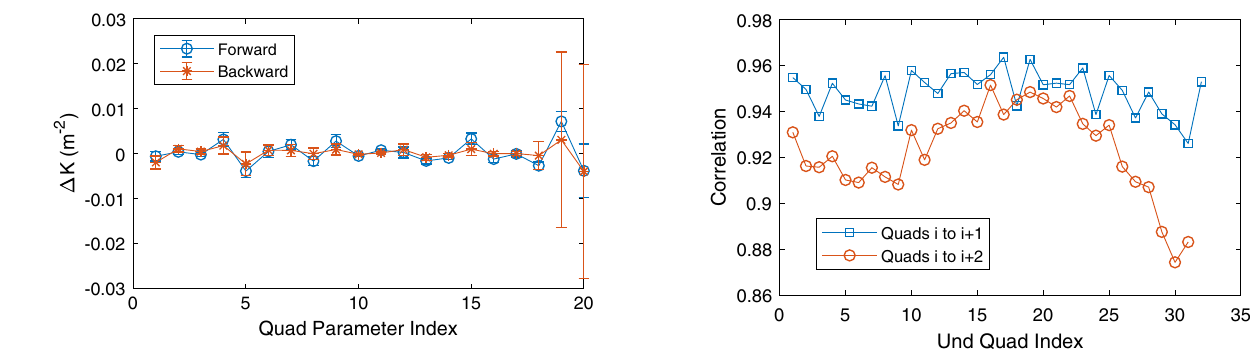
FIG. 18. Correlation coefficients of Jacobian matrix columns between adjacent quadrupole pairs (blue square) and second neighbor pairs (red circle) in the undulator section.